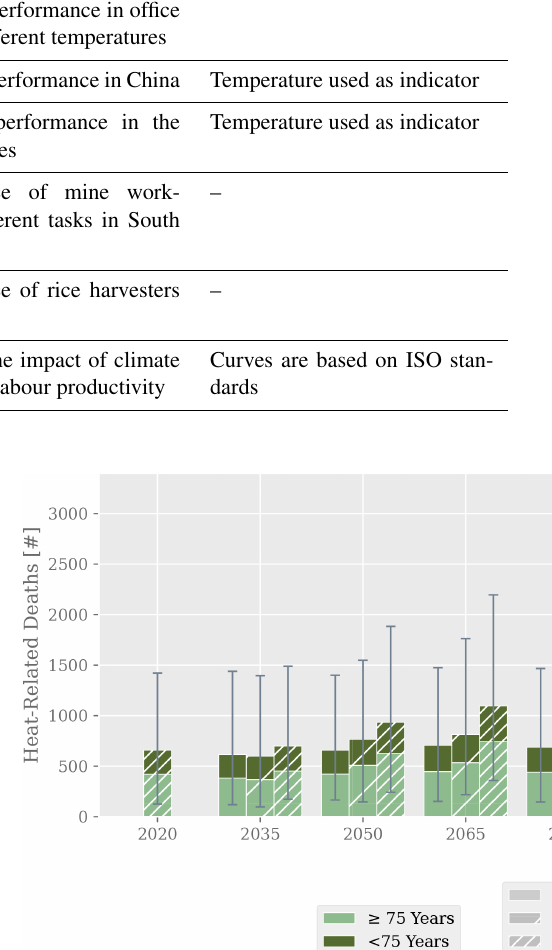
Fig. 4. Detailed maps showing the spatial distribution of the impact for 2050 can be found in Sect.